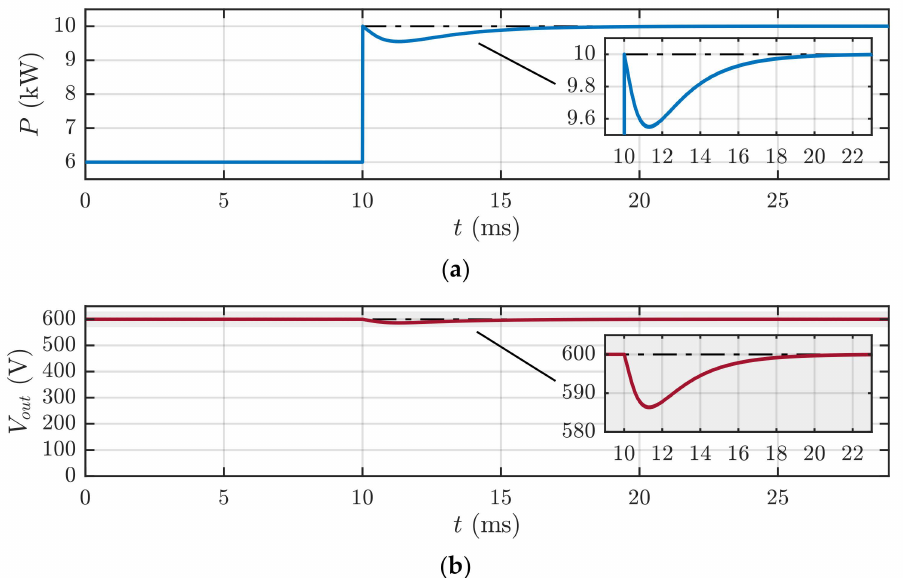
Figure 11. Output power ( a ) and output voltage ( b ) change on the DC bus when load changes from 6 kW to 10 kW with the proposed control method.